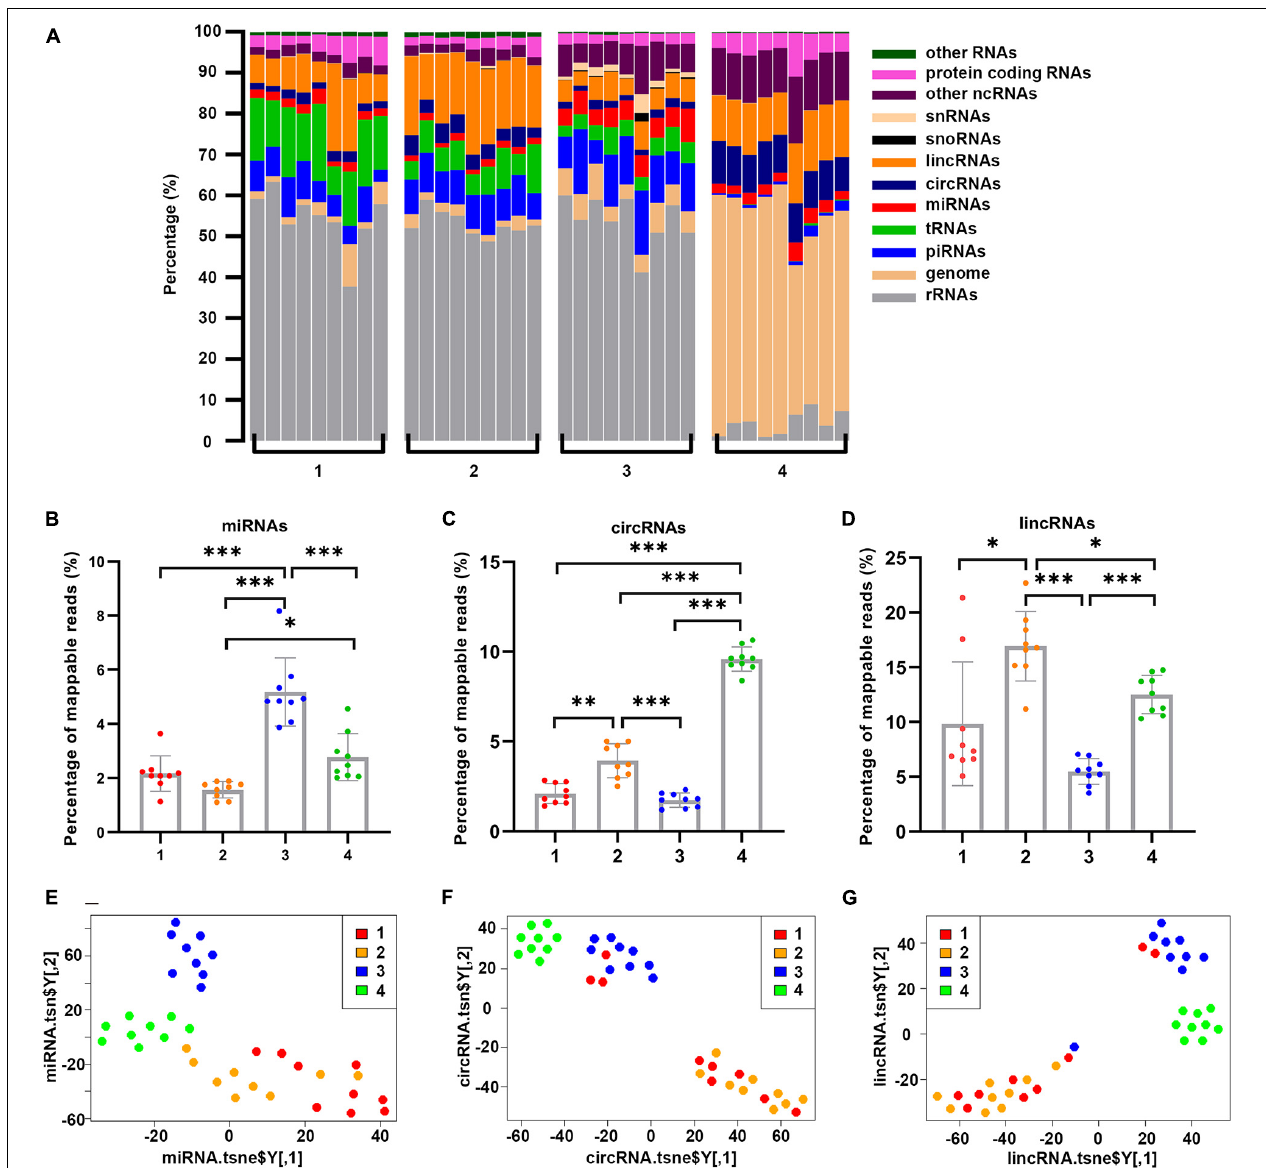
FIGURE 4 | Distribution and clustering of RNA transcripts in all samples of each fraction. (A) Percentage of each RNA species in fractionated samples, grouped by four different fractions. The vertical bar represents each sample. (B–D) Percentage of read counts in four fractions for miRNAs, circRNAs, and lincRNAs datasets. Significant enrichment of miRNAs in the EV Precipitate, circRNAs in the leftover, and lincRNAs in both the Precipitate 2 and leftover was observed (* p < 0.05, ** p < 0.01, *** p < 0.001, one-way ANOVA). (E–G) t-SNE plots for the 4 fractions based on genome, miRNAs, protein-coding transcript dataset. The numbers 1–4 represent fractions for Precipitate 1, Precipitate 2, EV Precipitate and the leftover,